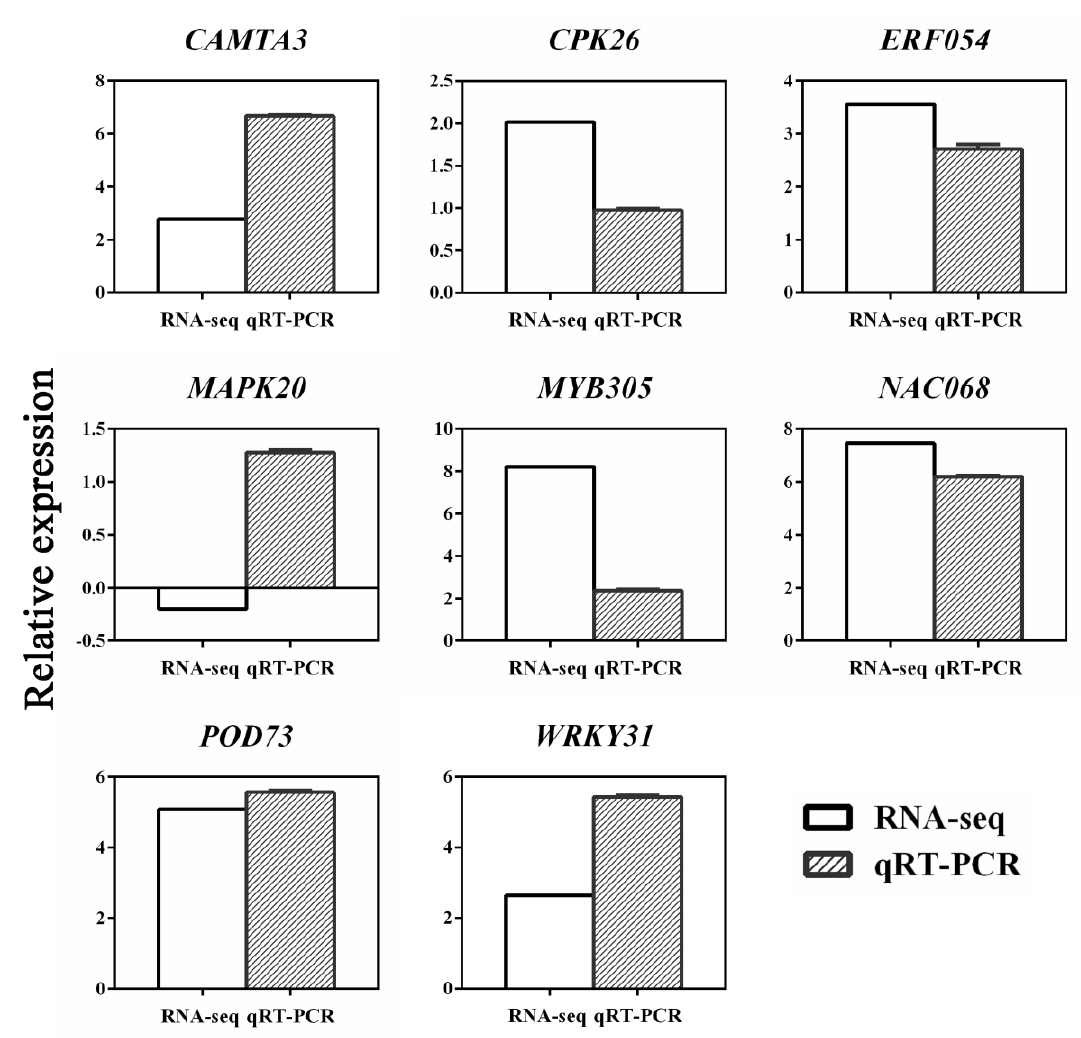
Figure 8. Comparison of expression patterns of 8 candidate genes between RNA-seq (white) and qRT-PCR (oblique line) for selected transcripts. Data represent the mean ± SD of three independent experiments. X axis is the selected gene ID, and Y axis is the log 2 Ratio.